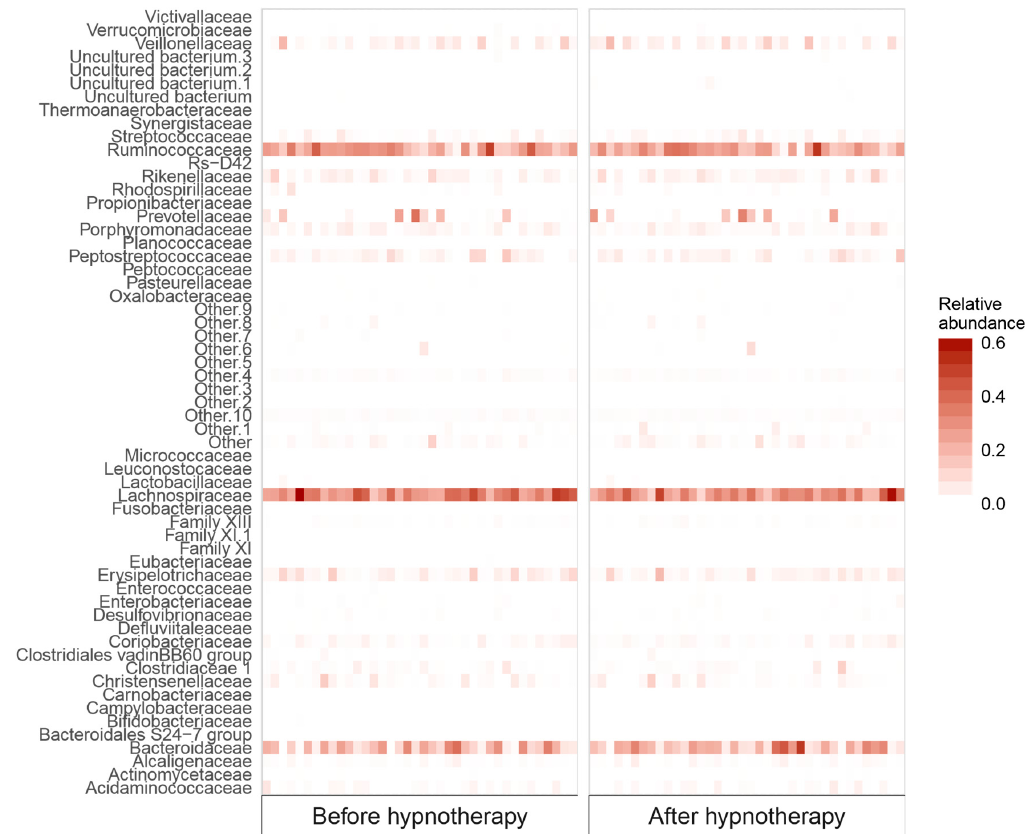
Figure 2. Heatmap of bacterial families before and after GHT.